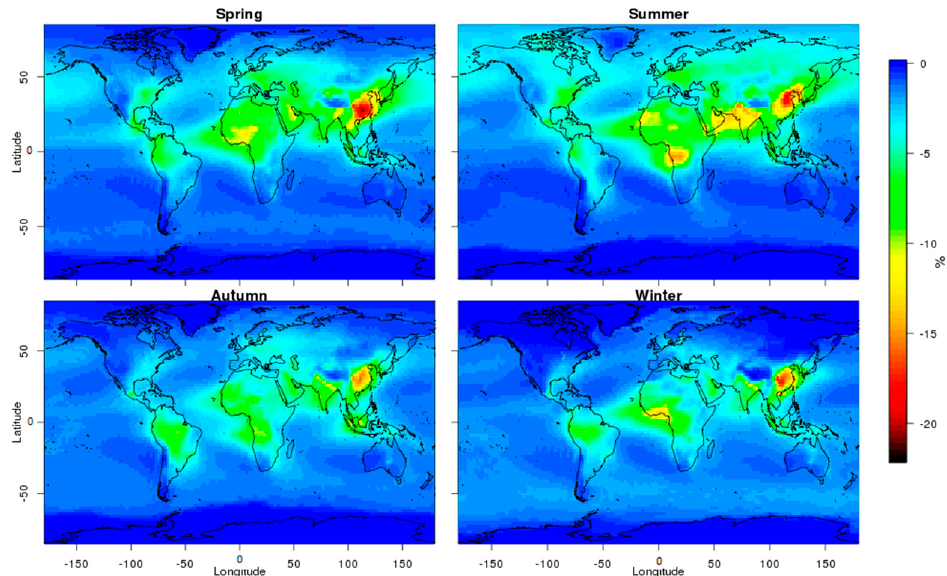
Figure 5. Global spatial distribution of seasonally averaged AOT effect during the period 2000–2019. AOT effect is quantified by Equation (2) and refers to the effects on downwelling SW irradiance reaching the Earth’s surface under different values of AOT.